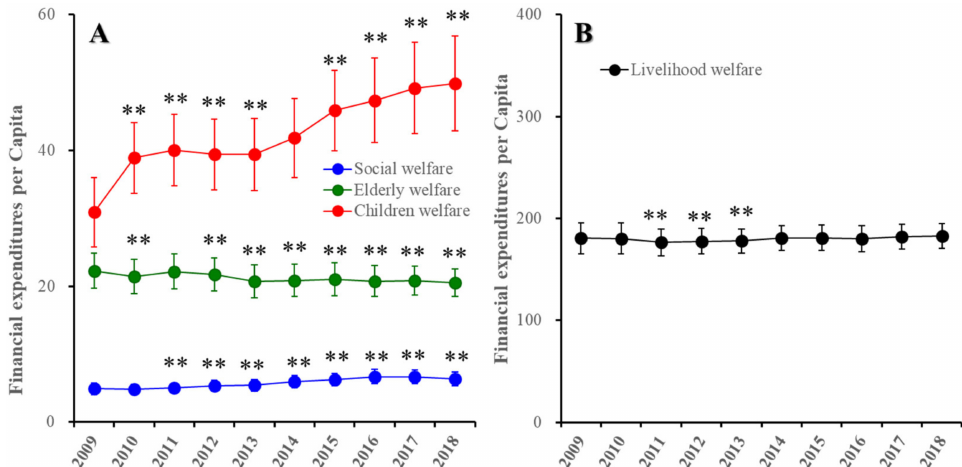
Figure 8. Trends of regional financial expenditures per capita of welfare subdivisions of social, elderly and child ( A ) and livelihood welfare ( B ) in Japan from 2009 to 2018. Ordinates indicate regional financial expenditure of prefecture and municipality (JPY 10,000 per capita). ** p < 0.01, relative to 2009 by linear mixed-effect model with Sidak’s post hoc